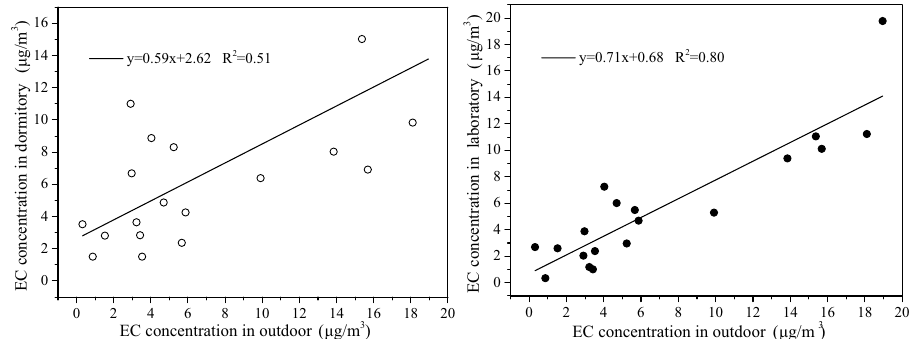
Figure 5. The regression analysis of EC concentration for dormitory and outdoor, laboratory and outdoor.